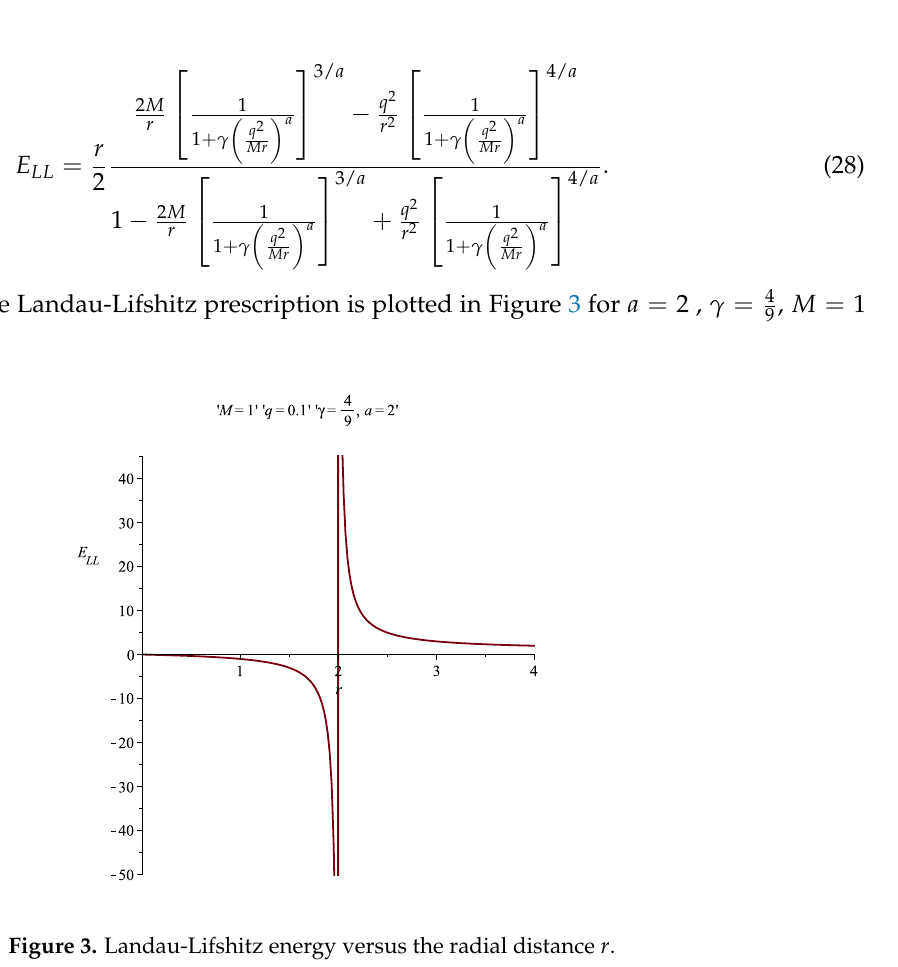
Figure 3. Landau-Lifshitz energy versus the radial distance r .